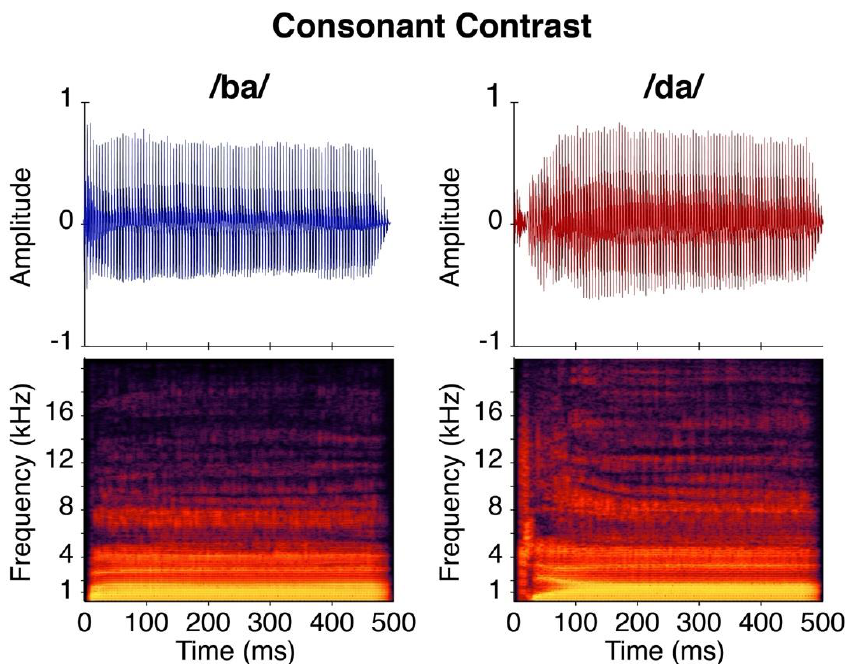
Figure 1. Time-amplitude waveforms and spectrograms for stimuli tested during the speech dis- crimination task. The top panel shows the /a/ and /i/ speech sounds for the vowel contrast and the bottom panel shows the /ba/ and /da/ speech sounds for the consonant. This figure was previously published in this open access journal, Uhler et al.